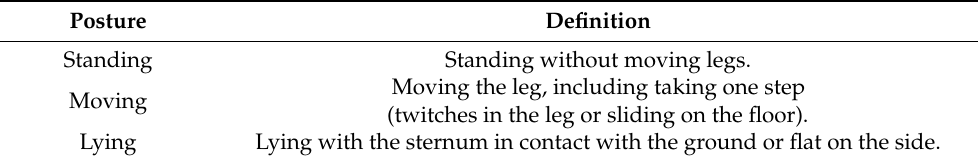
Table 2. Definitions for the postures observed during the study investigating the suitability of wearable cameras for monitoring juvenile bovine behavior.